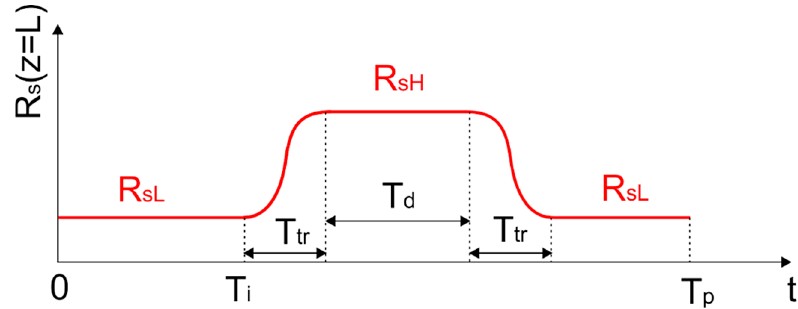
Figure 7. The time dependence of facet reflectivity at z = L for signal wave.